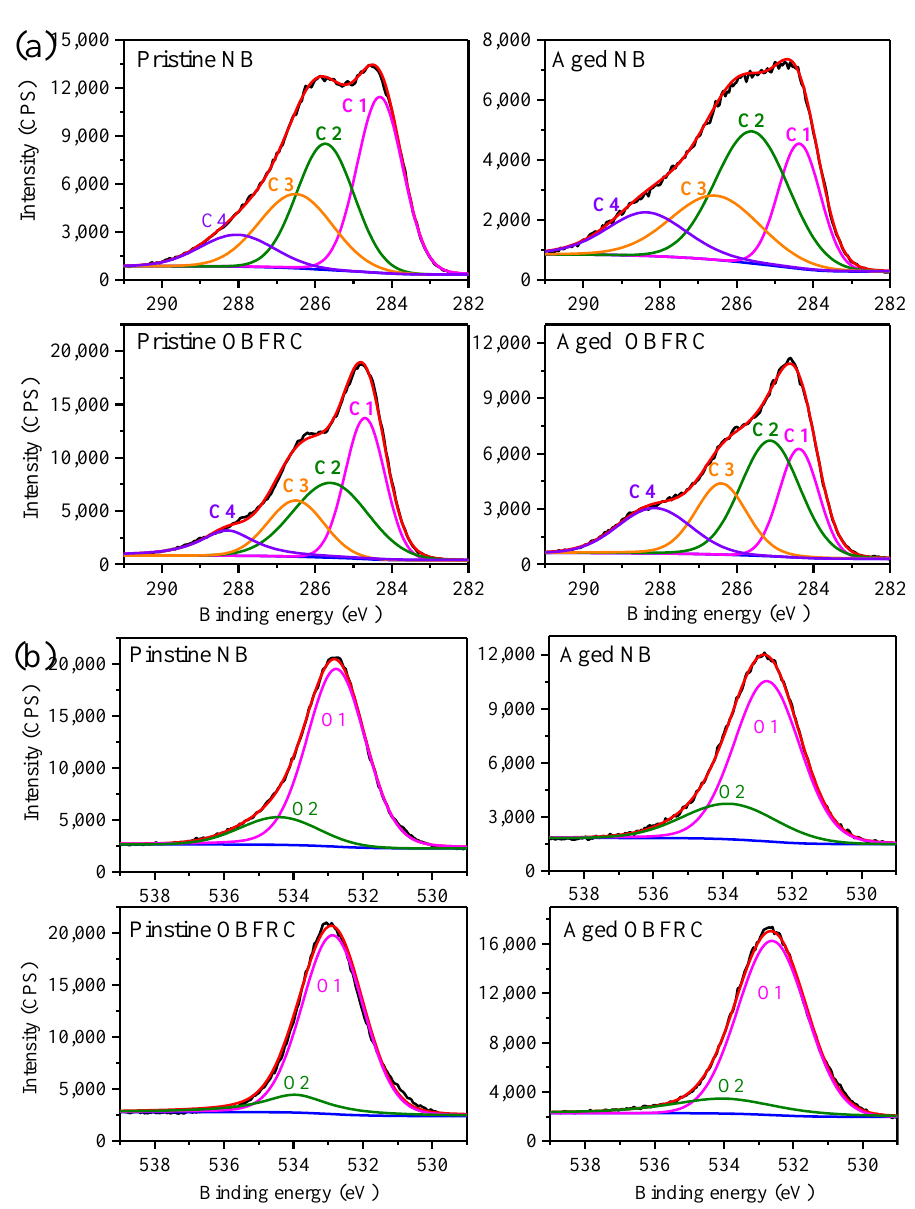
Figure 8. High-resolution XPS spectra of ( a ) C and ( b ) O peaks in NB and OBFRC before and after UV irradiation for 200 h. Table 3. Classification of carbon and oxygen peaks in spectra for NB and phenol-formaldehyde (PF) resin [31,45,46]. Element